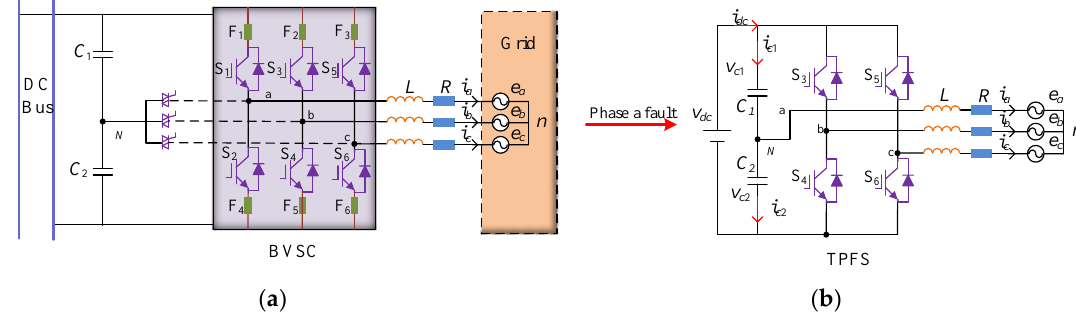
Figure 1. Fault-tolerant topology of a bidirectional voltage-source converter (BVSC). ( a ) Fault-tolerant structure of BVSC; ( b ) three-phase four-switch (TPFS) structure with Phase A fault.